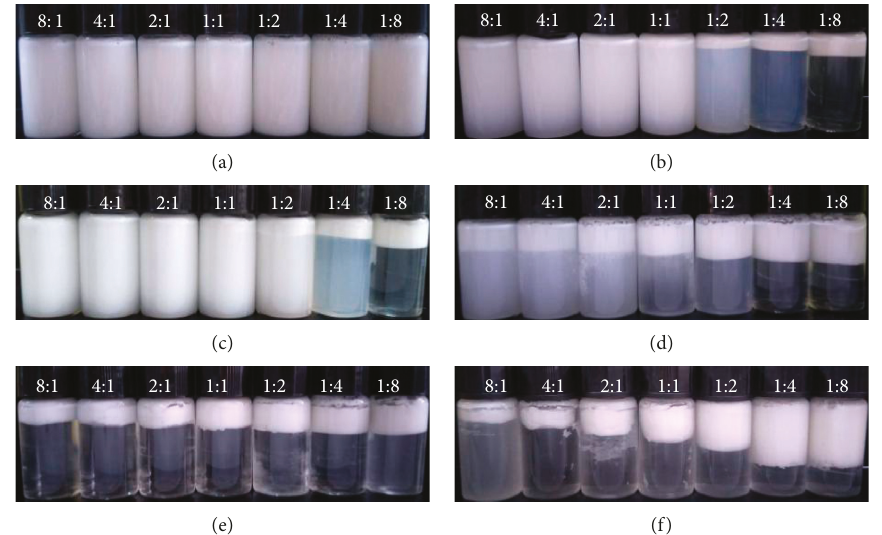
Figure 3: Photographs of BSA-WSC emulsions (containing 5% v/v oil) with different pH and biopolymer ratios ( R � BSA: WSC � 8 :1–1: 8). (a) Fresh emulsions and (b–f) emulsions with different pH values 3.0, 4.0, 5.0, 6.0, and 7.0 after 20-day storage at 25 °